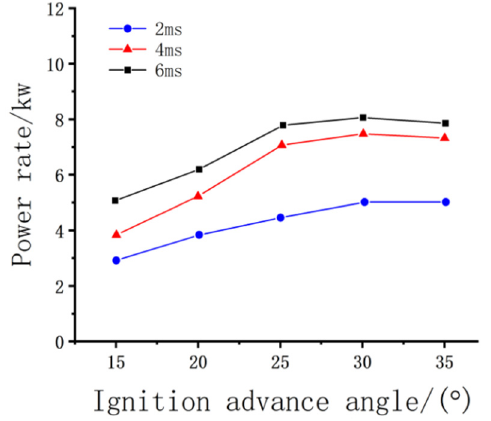
Figure 25. Influence of the ignition parameters on engine power.